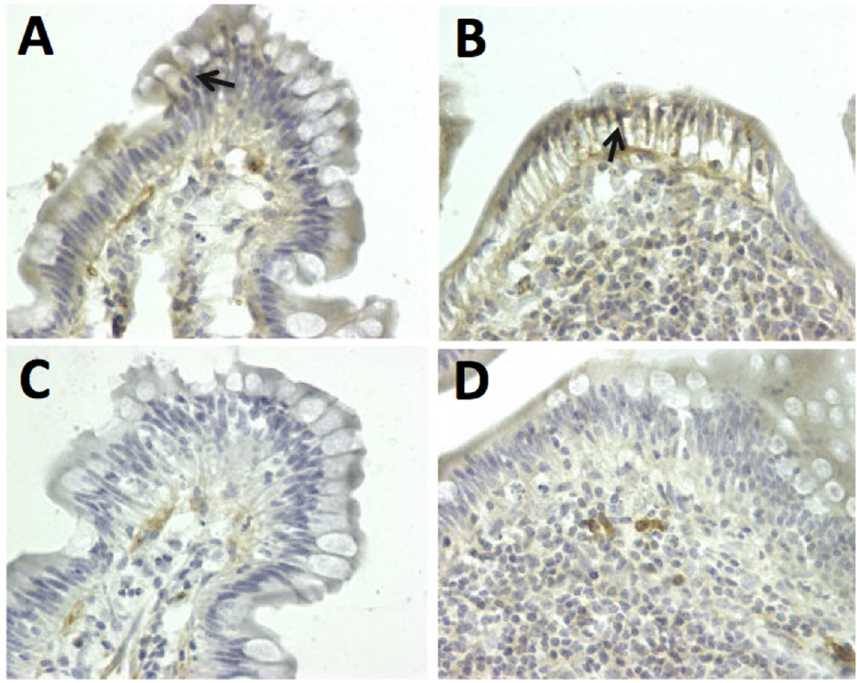
Figure 5. Jejunum biopsies collected from GS macaques on Bomi + B diet show an increased IL ‐ 15 staining, indicated by arrows ( A , B ) while lower intensity of such signal was detected in tissues stained with unrelated, isotype ‐ matched antibodies or in healthy control biopsies ( C , D ), magnification 40×.